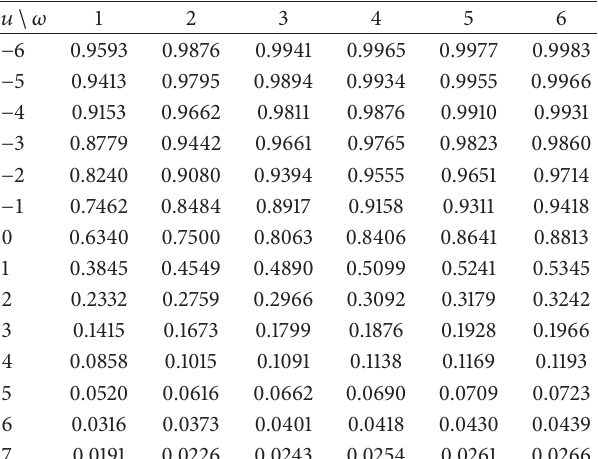
Table 3: Influence of 𝑢 and 𝜔 on 𝜓(𝑢,𝑏) for 𝛿 = 0.1 , 𝑐 = 2 , 𝜆 = 3 , 𝛼 = 1 , and 𝑏 = 10 .